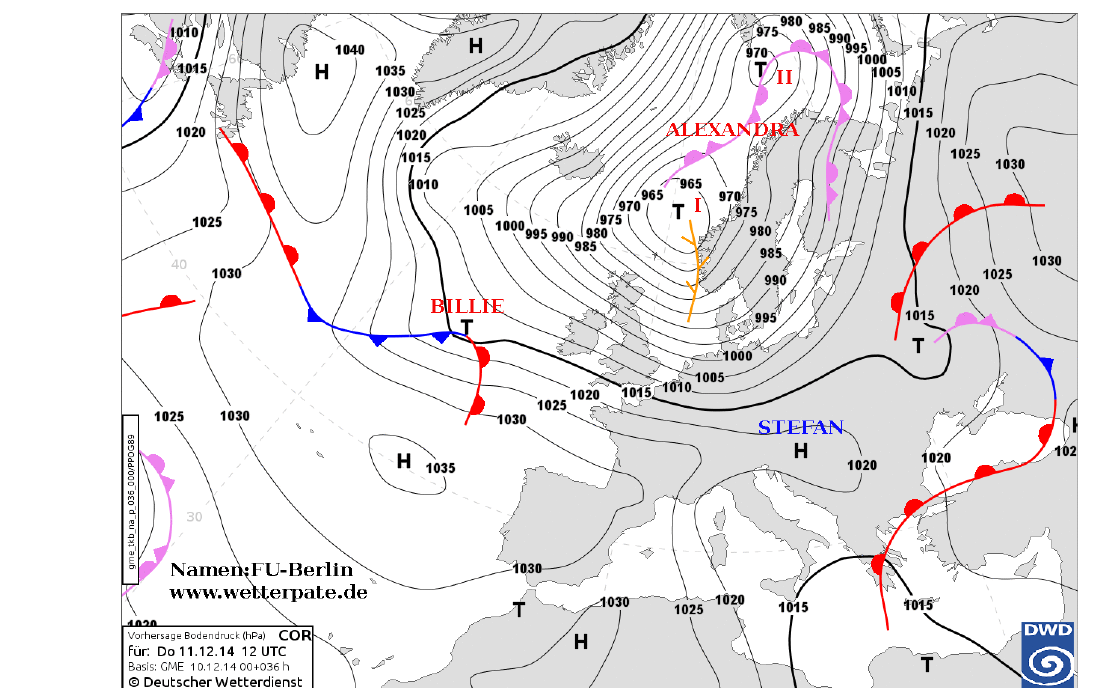
Figure 1. Sea level pressure prediction for Thursday, 11 December 2014, showing the low-pressure systems Alexandra and Billie in quick succession. Image credit: FU Berlin, www.met.fu-berlin.de (last access: 20 February